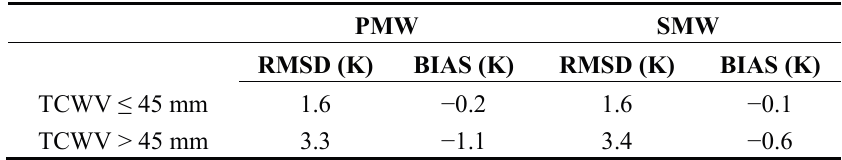
Table 2. Theoretical uncertainty for MSG/SEVIRI LST estimates for the PMW and SMW. RMSD and bias associated with both model and input uncertainty.